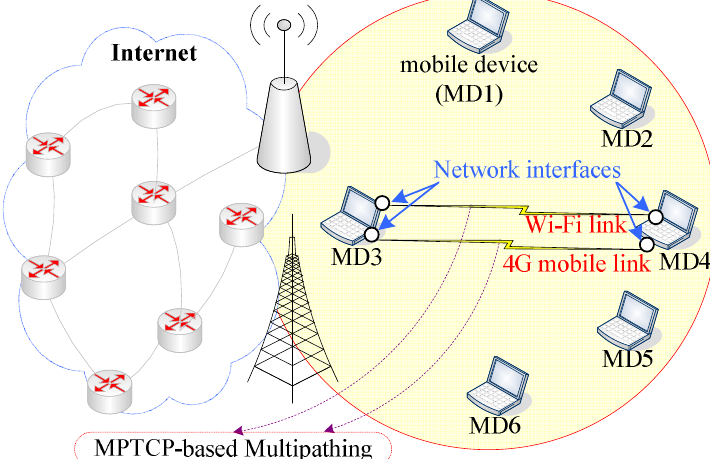
Figure 1. A typical Multipath TCP (MPTCP) based multipath communication among multihomed mobile